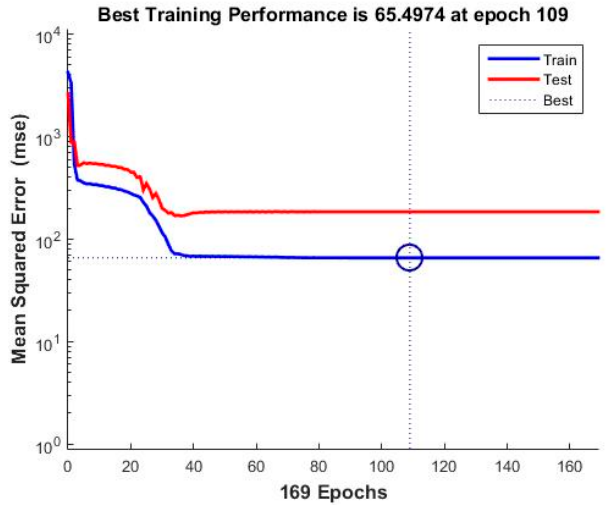
Figure 7. Training performance of the neural network.